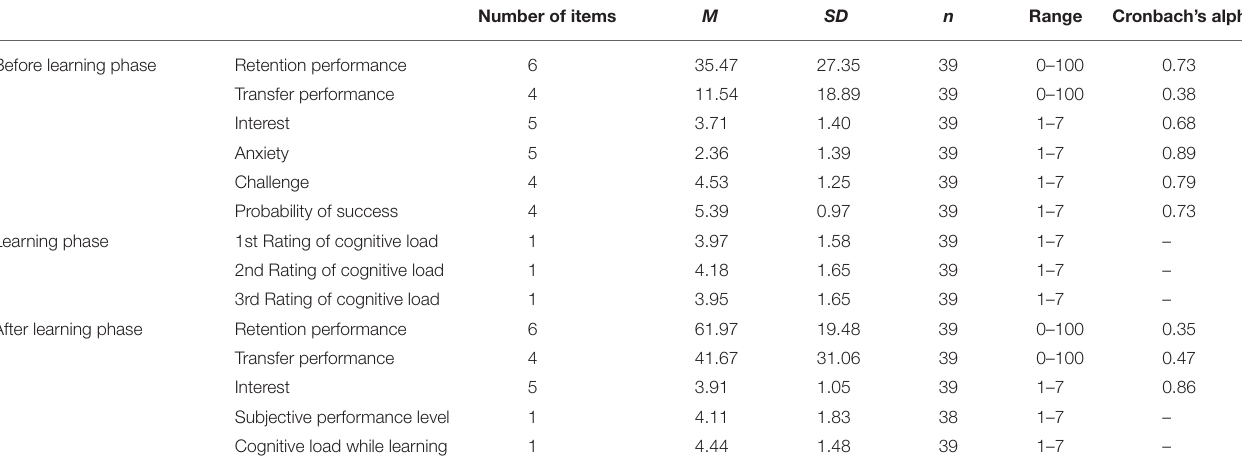
TABLE 3 | Descriptive statistics of the assessment used for statistical analyses.